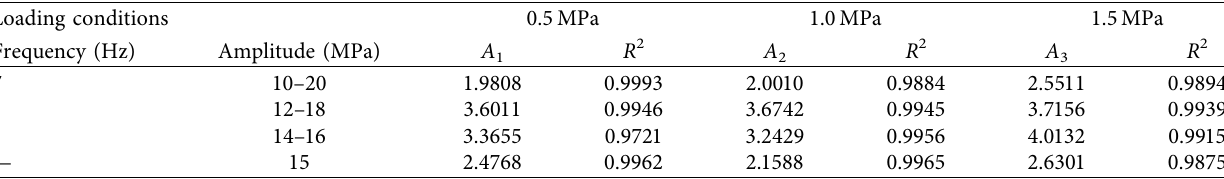
Table 6: Fitting results for the relationship between the desorption capacity of the briquette samples within 2.5min and the square root of time under different loading